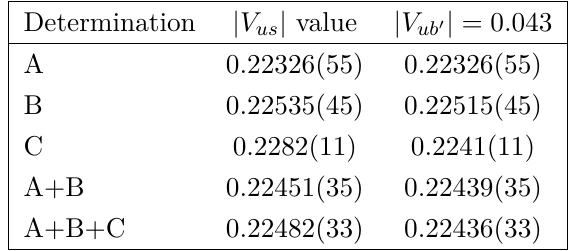
Figure 5 . Determinations of | V us | obtained using eq. (4.7) with | V ub 0 | = 0 . 043 , with the dataset in eqs. (2.3), (2.5), (2.14), to be compared with figure 2.